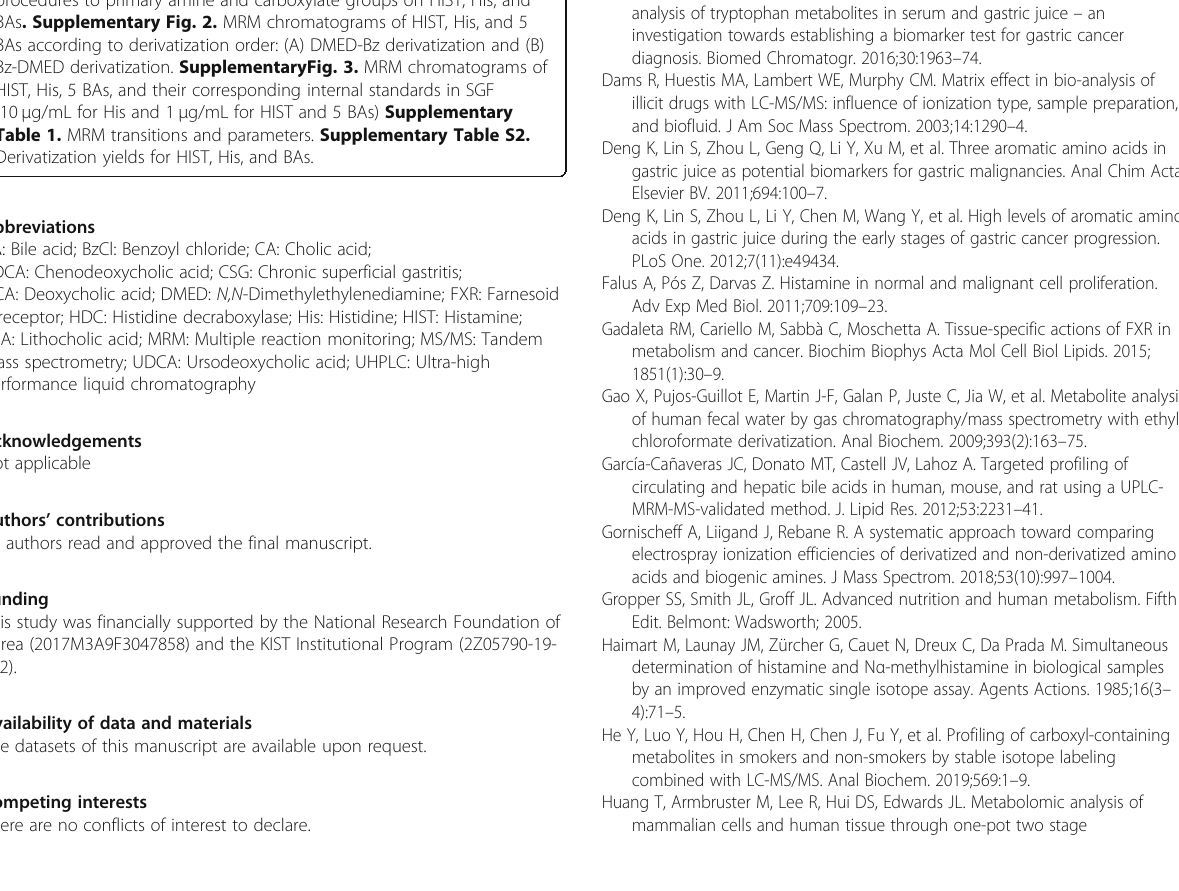
Additional file 1: Supplementary Fig. 1. Serial derivatization procedures to primary amine and carboxylate groups on HIST, His, and BAs . Supplementary Fig. 2. MRM chromatograms of HIST, His, and 5 BAs according to derivatization order: (A) DMED-Bz derivatization and (B) Bz-DMED derivatization. SupplementaryFig. 3. MRM chromatograms of HIST, His, 5 BAs, and their corresponding internal standards in SGF (10 μ g/mL for His and 1 μ g/mL for HIST and 5 BAs) Supplementary Table 1. MRM transitions and parameters. Supplementary Table S2. Derivatization yields for HIST, His, and BAs.